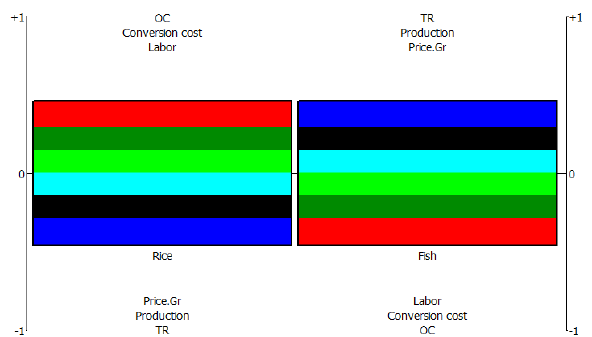
Figure 3: PROMETHEE rainbow chart for small-scale farm in equal weight situation (Source: Field survey,